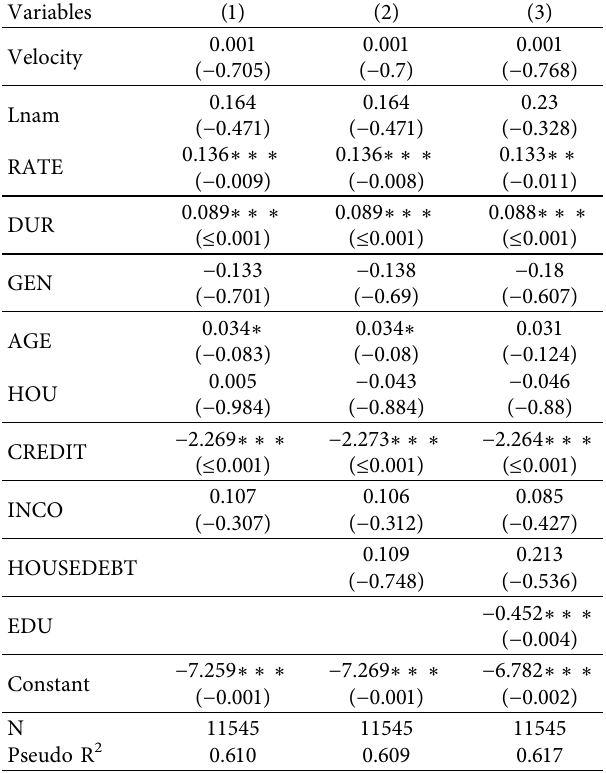
Table 11: Robustness test for hypothesis